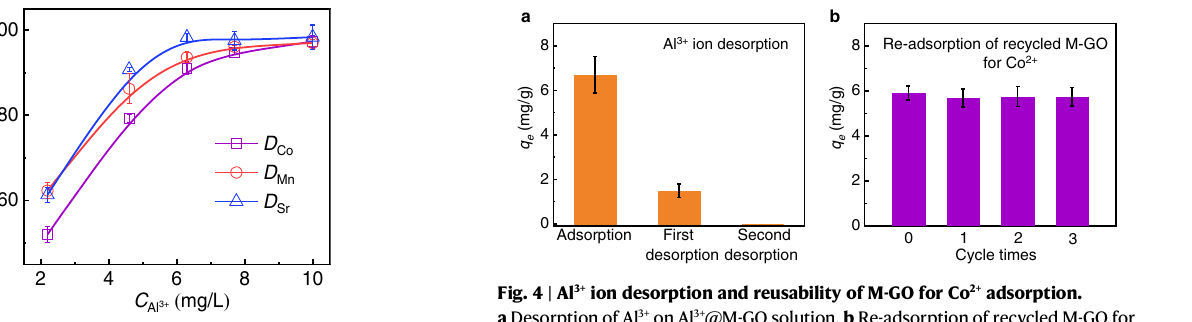
Fig. 3 | Desorption rate for Co 2+ , Mn 2+ , and Sr 2+ ions on M-GO analyzed by addition of Al 3 + . Error bars indicate the standard deviation from three different samples.